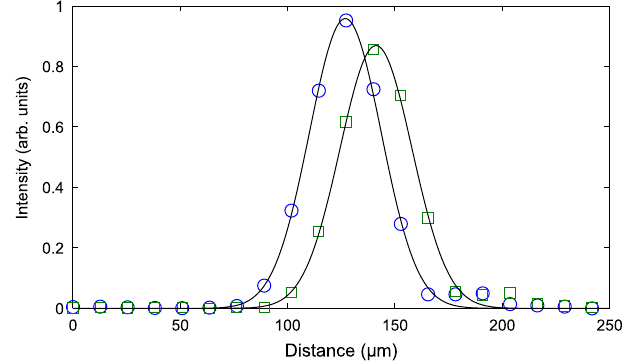
FIG. 4. The peaks from two neighboring DMD mirrors are 16 (cid:1) m apart. Since the measurements are not space charge limited, the difference in power from the two mirrors has no effect on measured